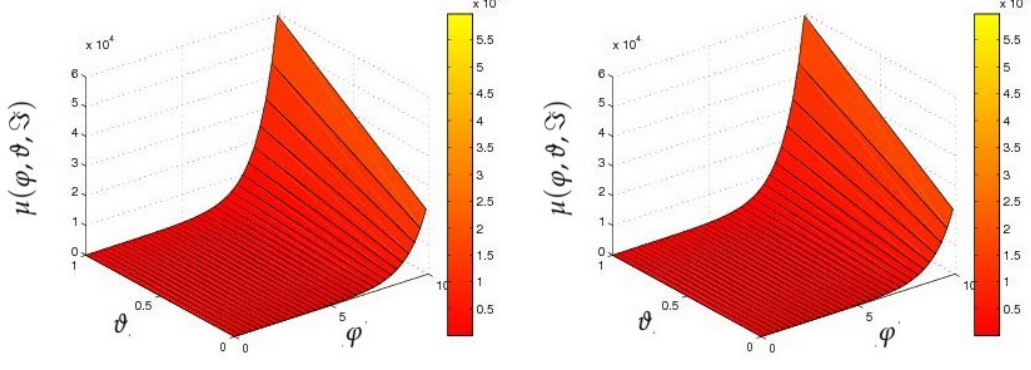
Figure 3. The HPTM graphs of δ = 1 and 0.8 of µ ( ϕ , ϑ ) , Example 1.